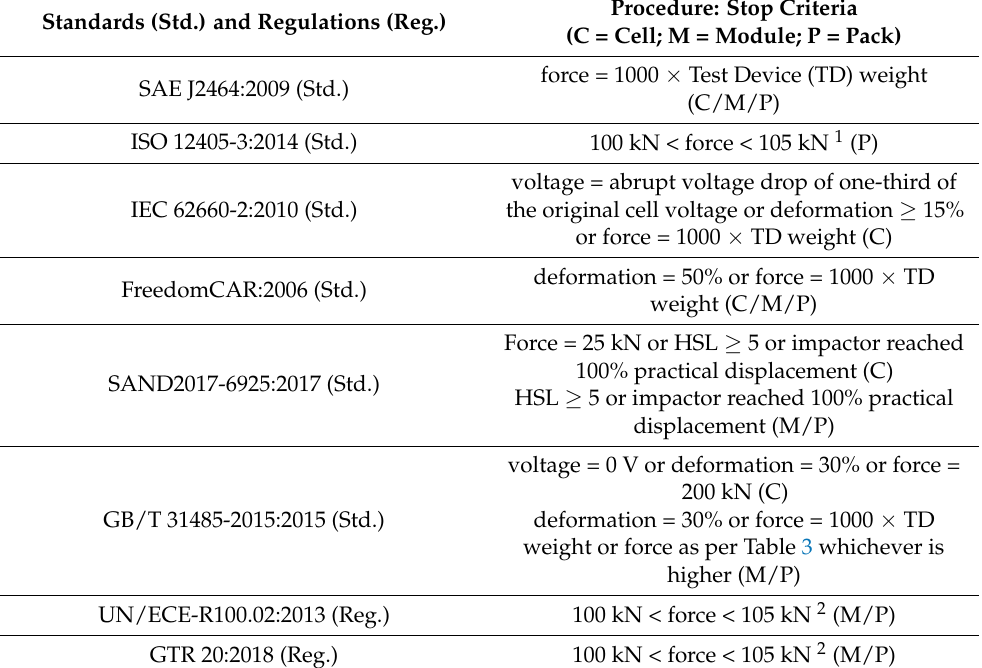
Procedure: Stop Criteria